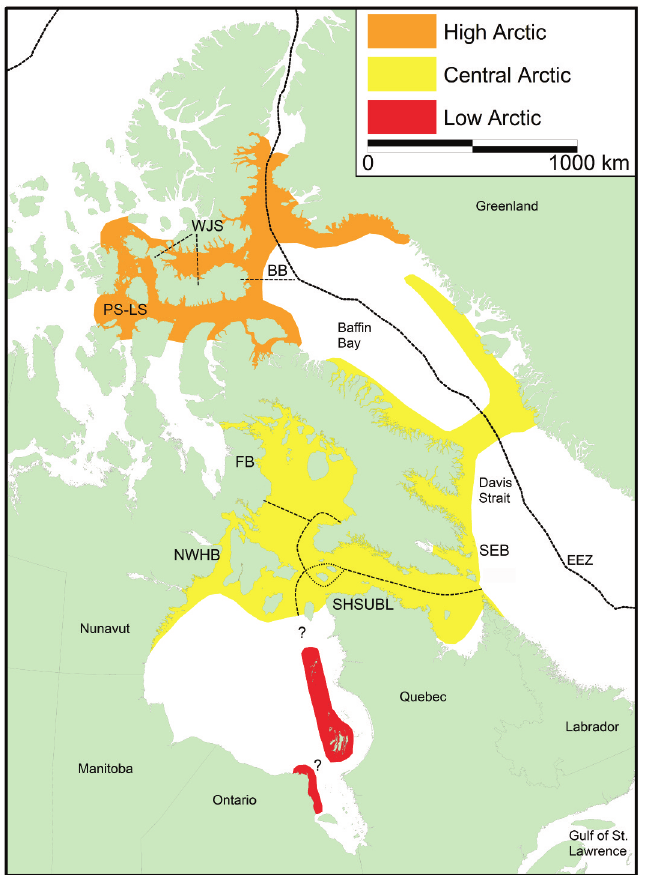
Walrus of the North Atlantic 220